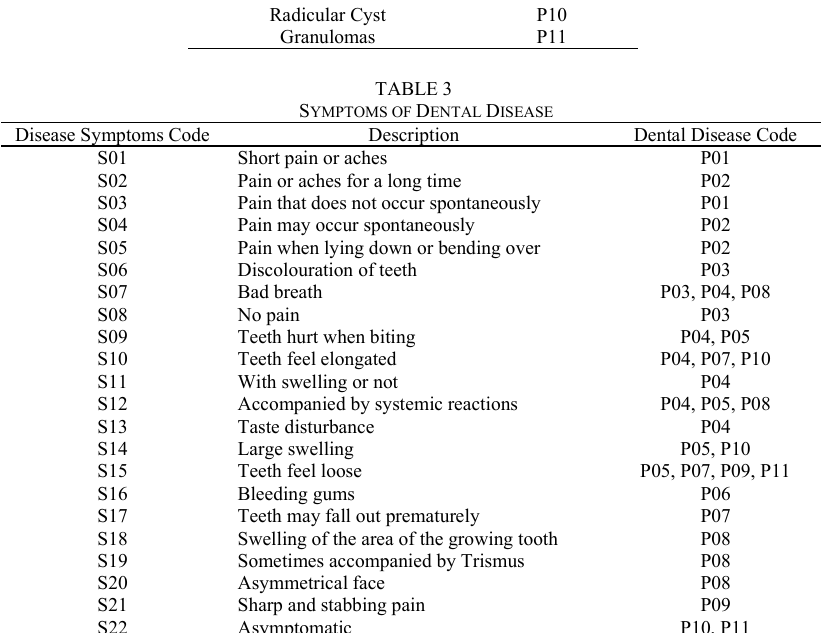
TABLE 3 S YMPTOMS OF D ENTAL D